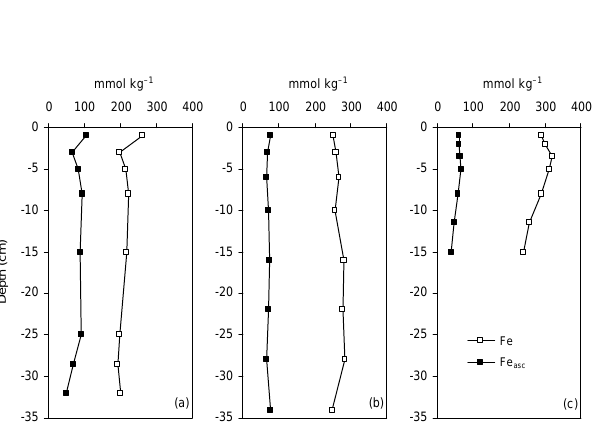
Fig. 5. Concentration-depth profiles of total Mn and ascorbate- extractable Mn (Mn asc ) in the sediments of (a) Lake Shirokoe (3rd stage), (b) Lake Yamsovey (4th stage), and (c) Lake Khasyrei (5th stage). Figure 5 Audry et al.